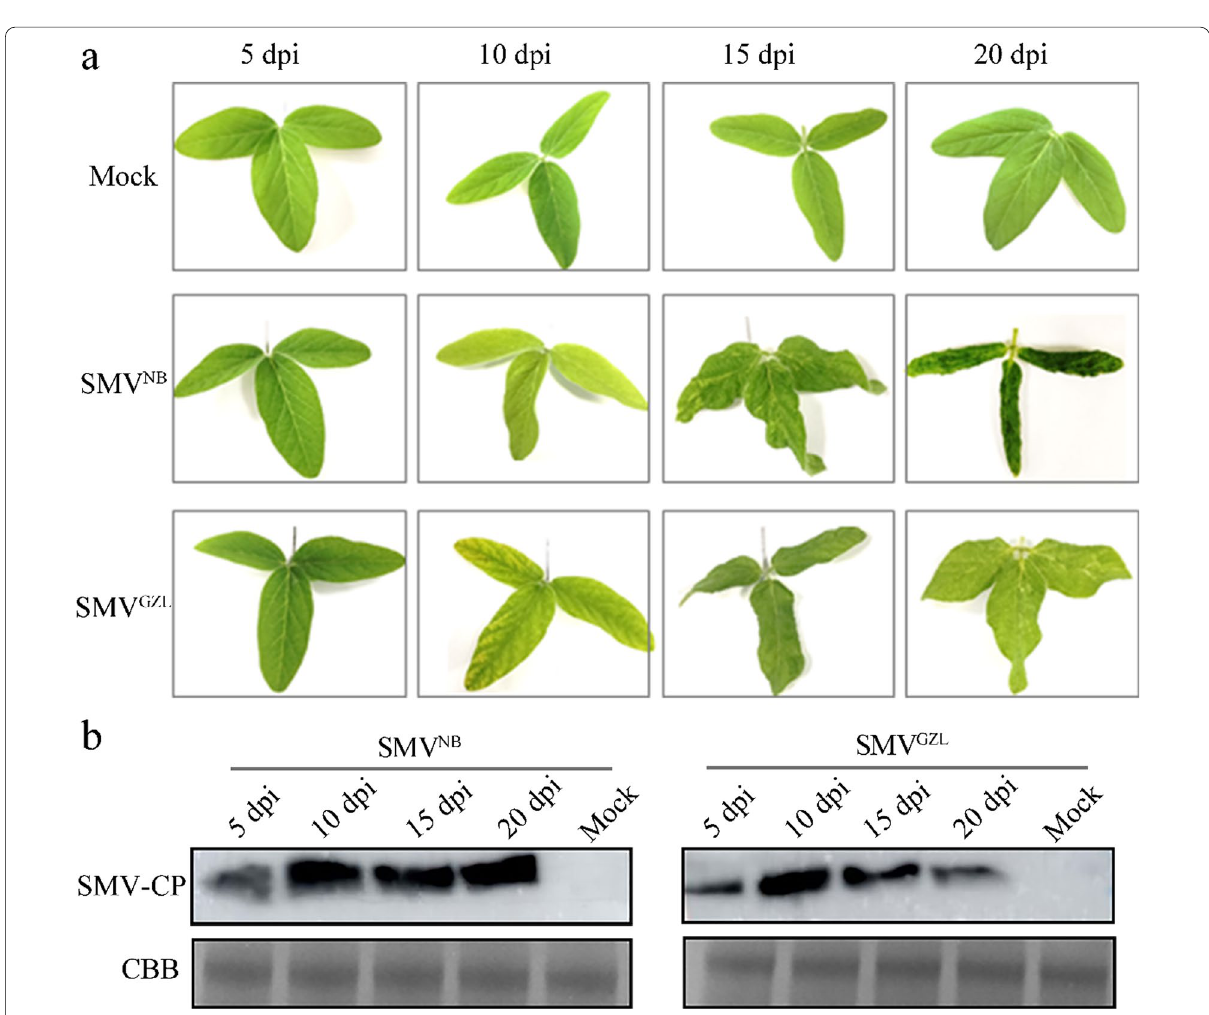
Fig. 2 Symptom development on soybean plants at different time points after inoculation with SMV GZL or SMV NB . a Symptoms on systemic (non-inoculated) leaves of Dongnong 51 plants at 5, 10, 15 and 20 dpi. b Immunoblots showing levels of SMV coat protein (CP) in plants mock-inoculated or inoculated with SMV NB /SMV GZL at different time points after inoculation. Coomassie brilliant blue (CBB) staining of the same extracts shows equal